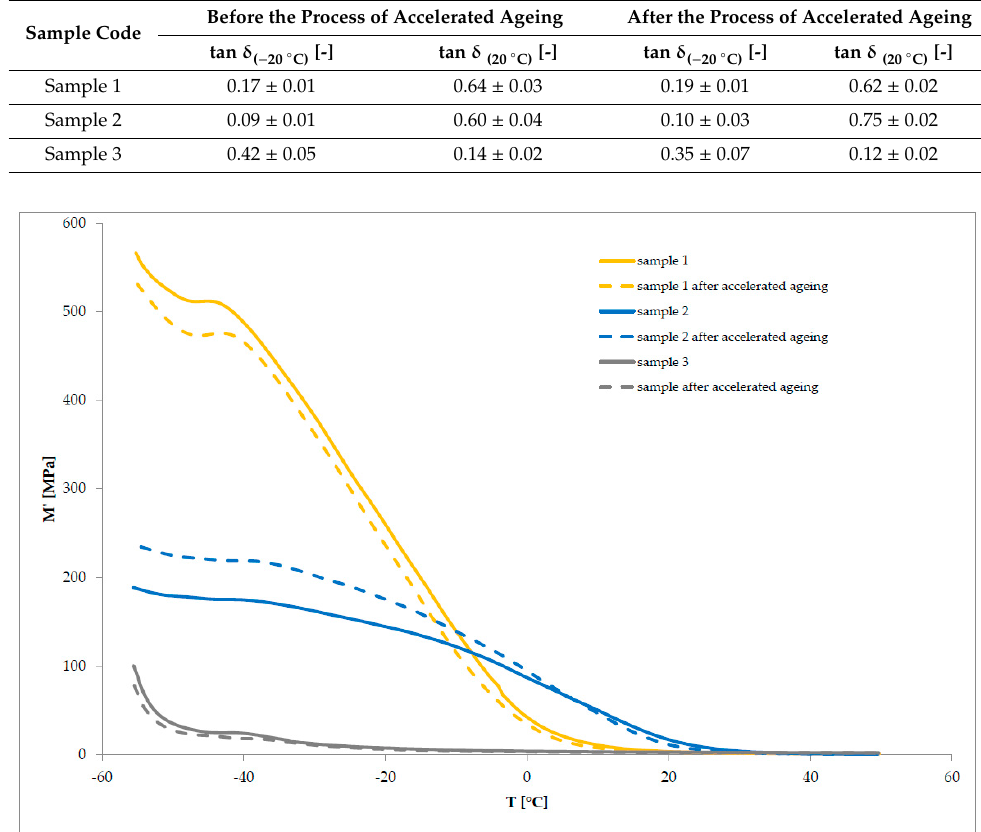
Figure 5. The storage modulus E’ in relation to the temperature of sample 1, sample 2, and sample 3, before and after the process of accelerated aging.